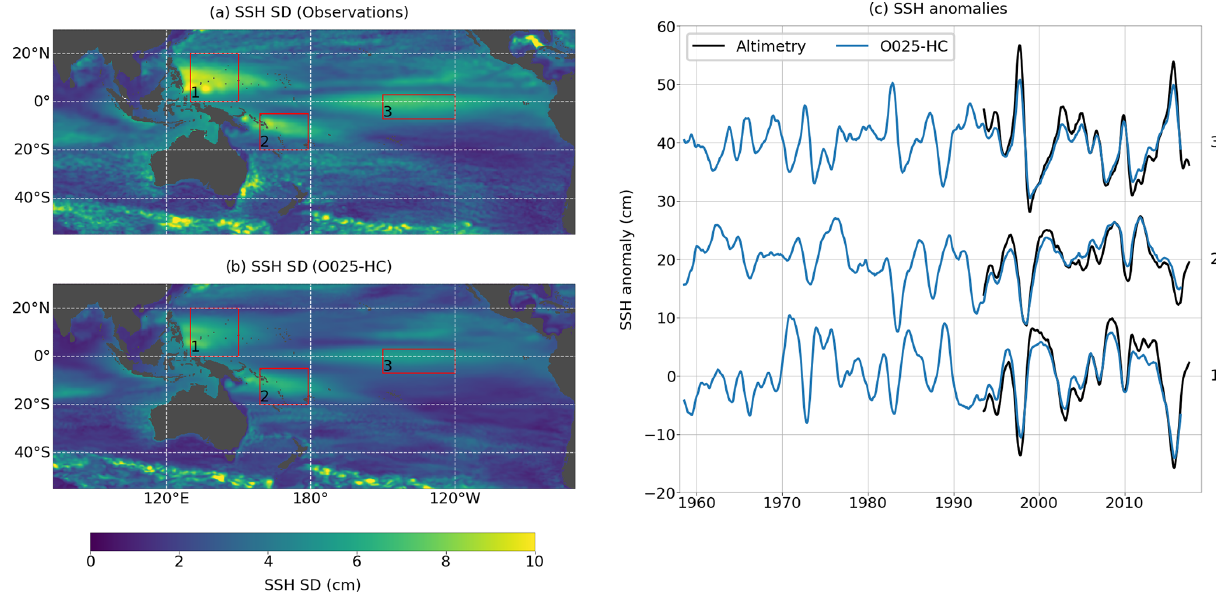
Figure 1. Standard deviation (SD) of SSH from (a) observations and (b) model simulation O025-HC. (c) SSH anomalies from observations and O025-HC averaged over three areas indicated by red boxes on the maps. Note that in panel (c) a constant offset of 20 and 40cm was added to anomalies from box 2 and 3 respectively. SD is based on the period from 1993 to 2016. The global mean trends have been subtracted, and all data were smoothed with a 12-month running-mean window prior to calculation.